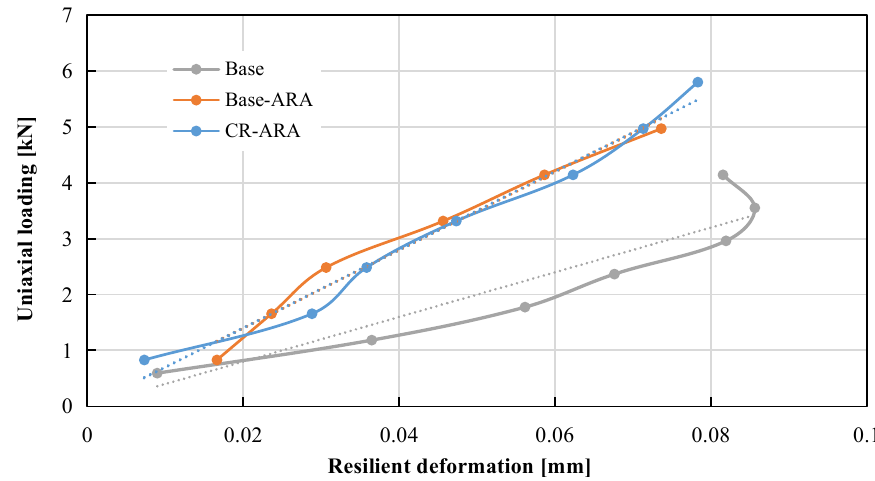
Figure 10. Relationship between uniaxial loading and resilient modulus of all specimens.